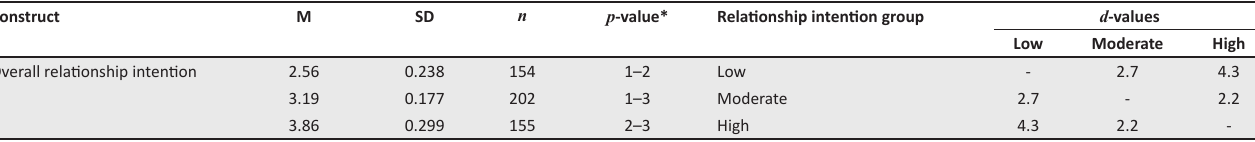
TABLE 3: Effect sizes for overall relationship intention for different relationship intention groups. Construct M SD n